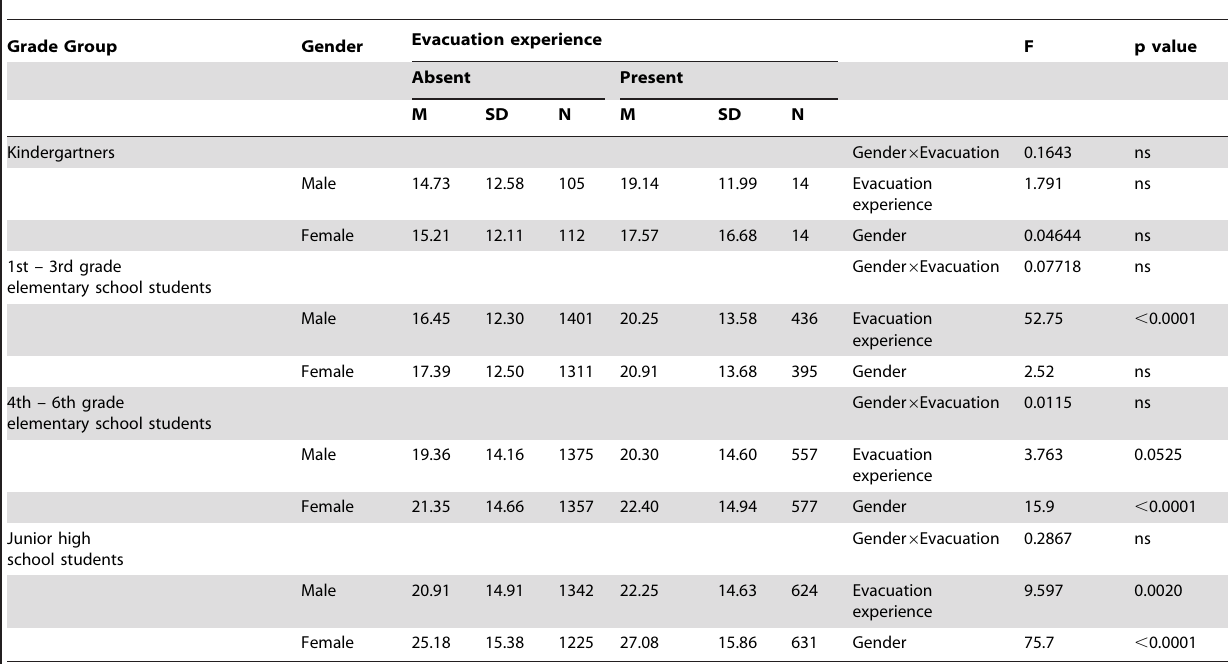
Table 4. Average PTSSC-15 score (grade & gender & evacuation experience).